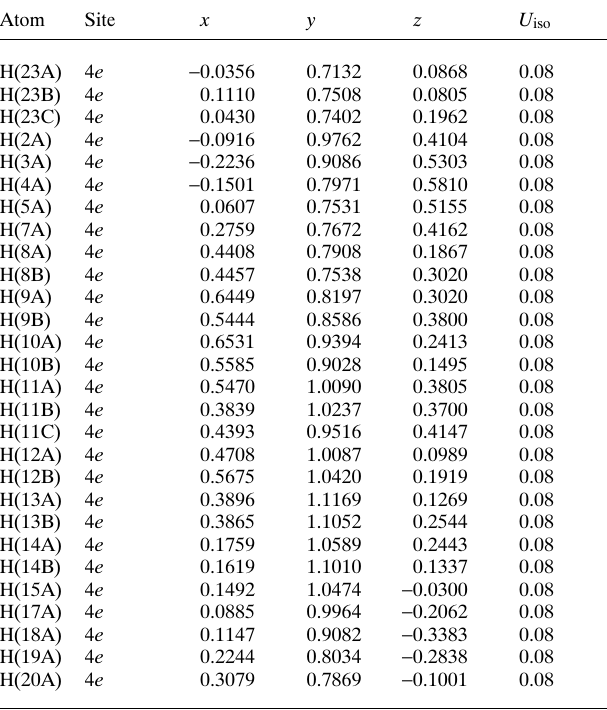
Table 2. Atomic coordinates and displacement parameters (in Å 2 )